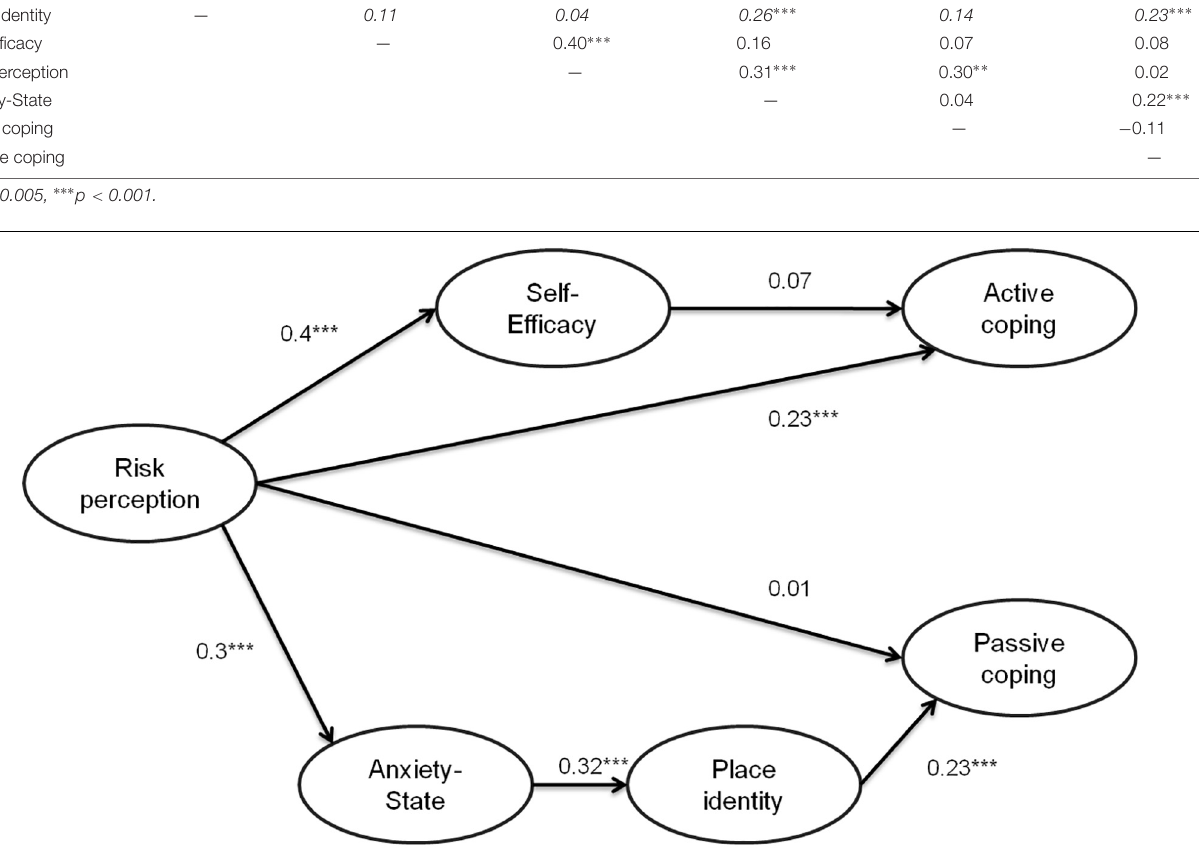
TABLE 4 | Correlation matrix of the relations between place identity, self-efficacy, risk perception, anxiety-state and active and passive coping. Place identity Self-efficacy Risk perception